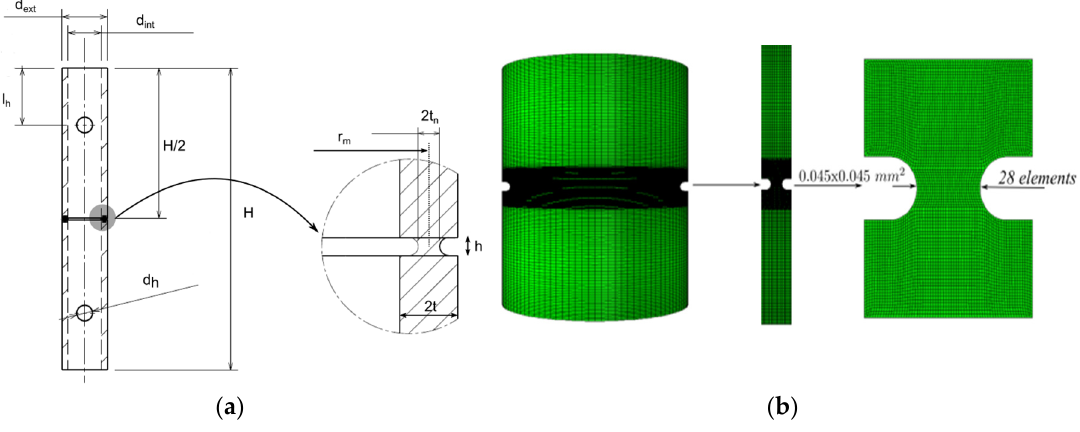
Figure 3. ( a ) Geometry and dimensions of DNT specimen; ( b ) numerical model of DNT specimen.